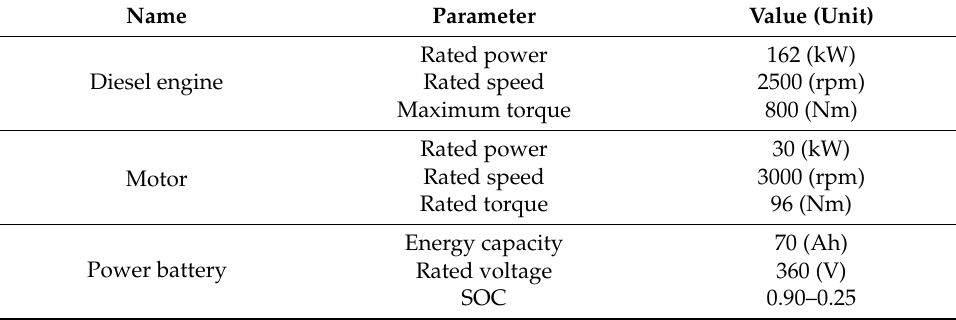
Table 1. Topology of a diesel–electric parallel hybrid tractor.